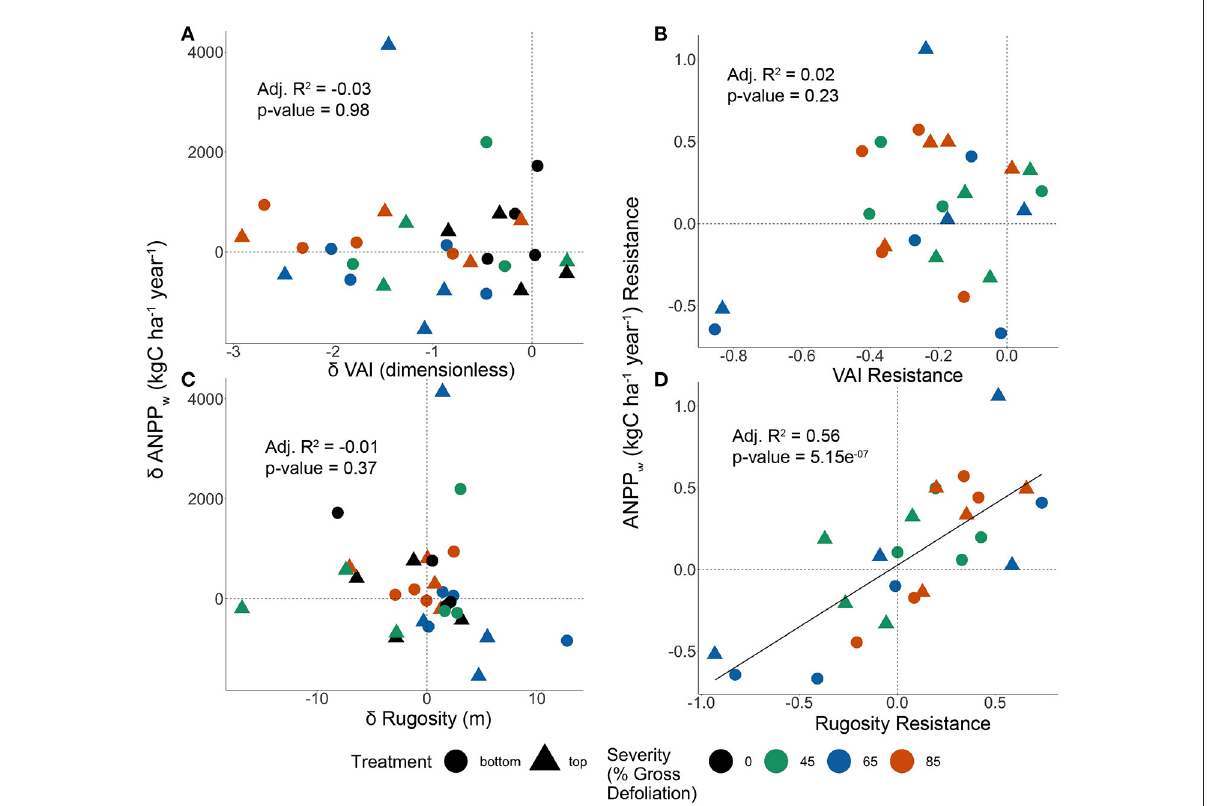
FIGURE5 Linear regressions relating change in vegetation area index (VAI) to change in aboveground wood net primary production (ANPP w ) (A) ; VAI resistance to ANPP w resistance (B) ; change in canopy rugosity to change in ANPP w (C) ; and rugosity resistance to ANPP w resistance (D) . A solid trendline is included when a significant relationship is present ( p < 0.05) (A,C) . Where changes in structural metrics over time are shown, a decrease in structural metric (x < 0) over time represents structures that existed before disturbance that remain 3 years after, while an increase in structural metric (x > 0) over time represents structures that were generated by disturbance (B,D) . Where structural resistance is shown, a decrease in structural metric relative to the control (x < 0) is designated as net negative resistance, while an increase in structural resistance (x > 0) is designated as net positive